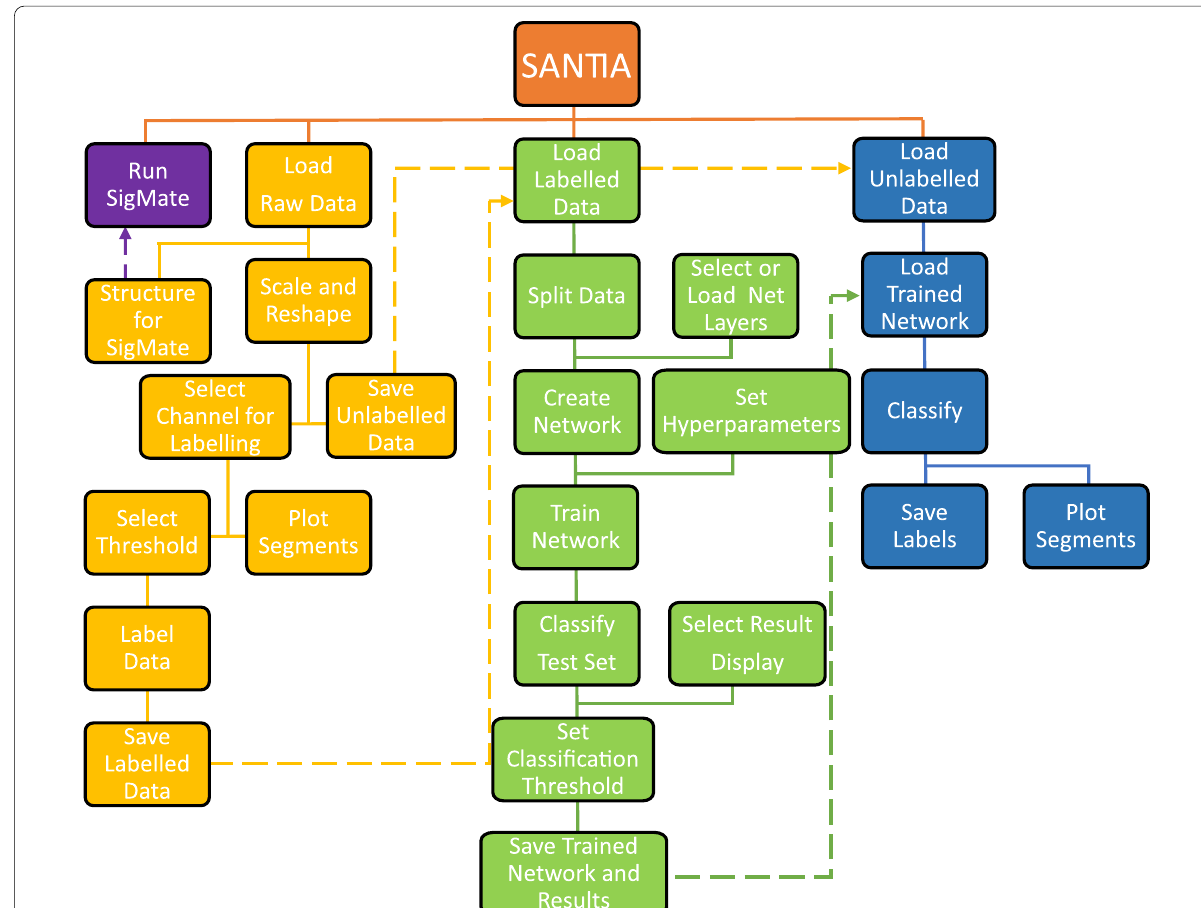
Fig. 6 Workflow of the SANTIA toolbox, where the “Data Labeling” modules are colored yellow, the “Neural Network Training” modules in green, and “Classify New Unlabeled Data” modules in